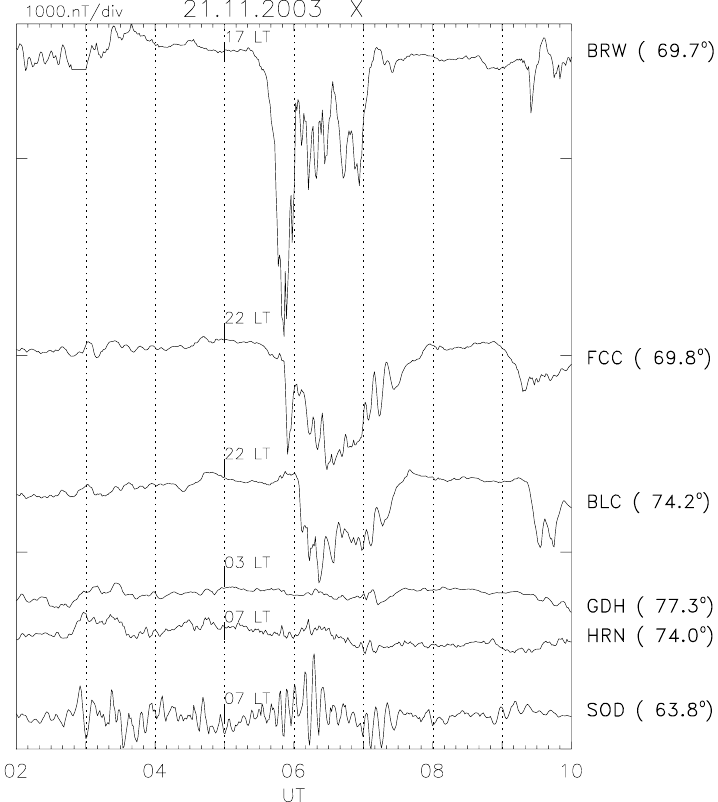
Fig. 8. The comparison of the morning Pc5 pulsation (SOD) occurrence with the substorm activity in the evening (BRW, FCC, and BLC) and morning polar cap (HRN, GDH) magnetic